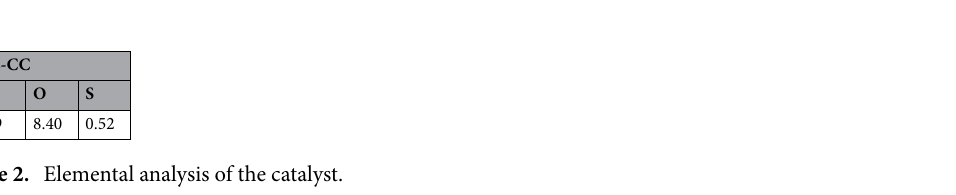
Figure 2. SEM images of derived catalysts Acid Functionalized Activated Corncob.